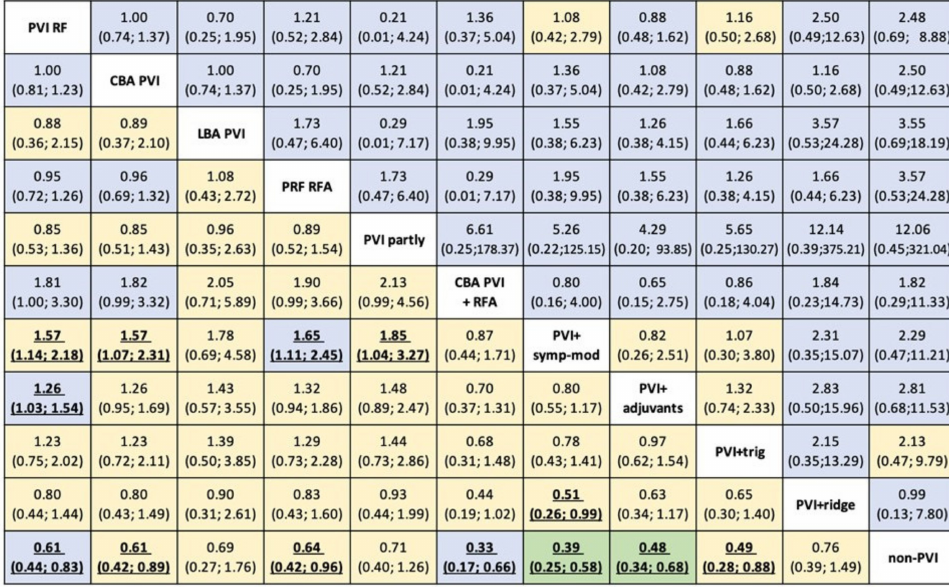
Figure 4. Risk ratios (RRs) for efficacy (lower triangle) and safety (upper triangle) with 95% CIs from network meta-analysis for 11 AF strategies available. Each cell is coloured by the certainty of evidence assessed for each comparison with CINeMA and classified as high (in green), moderate (in blue), low (in yellow). Abbreviations: CBA: cryoballoon ablation, HBA: hot balloon ablation, LBA: laser balloon ablation, PVI: pulmonary vein isolation, RFA: radiofrequency ablation, trig: trigger ablation, PRF: phase duty-cycled radiofrequency